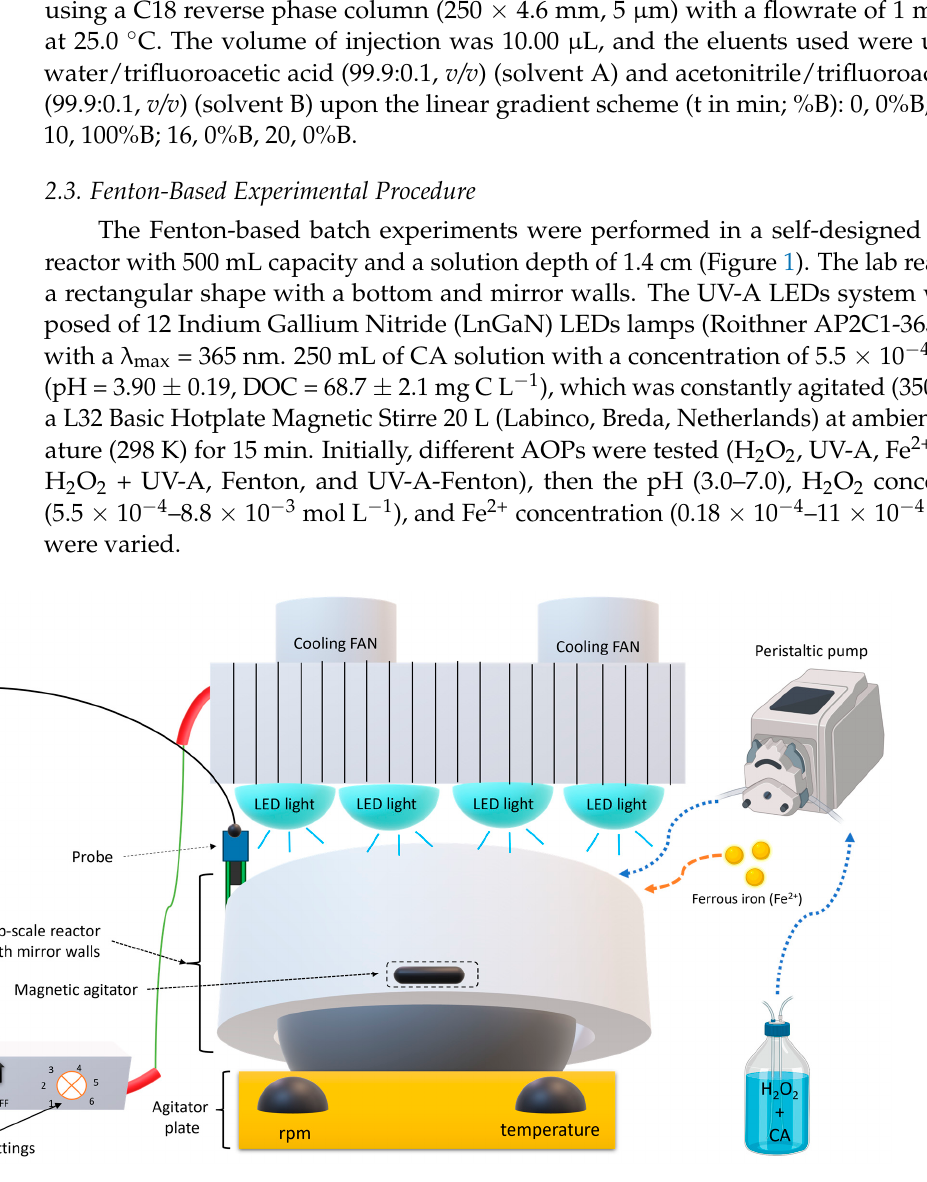
Figure 1. Schematic representation of UV-A LEDs lab-scale reactor with peristaltic pump.